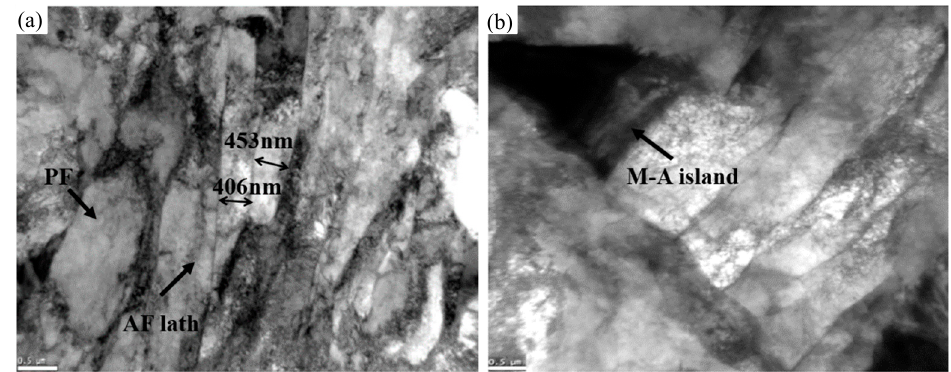
Figure 5. Transmission electron micrographs: ( a ) AF and PF, ( b ) M-A islands.